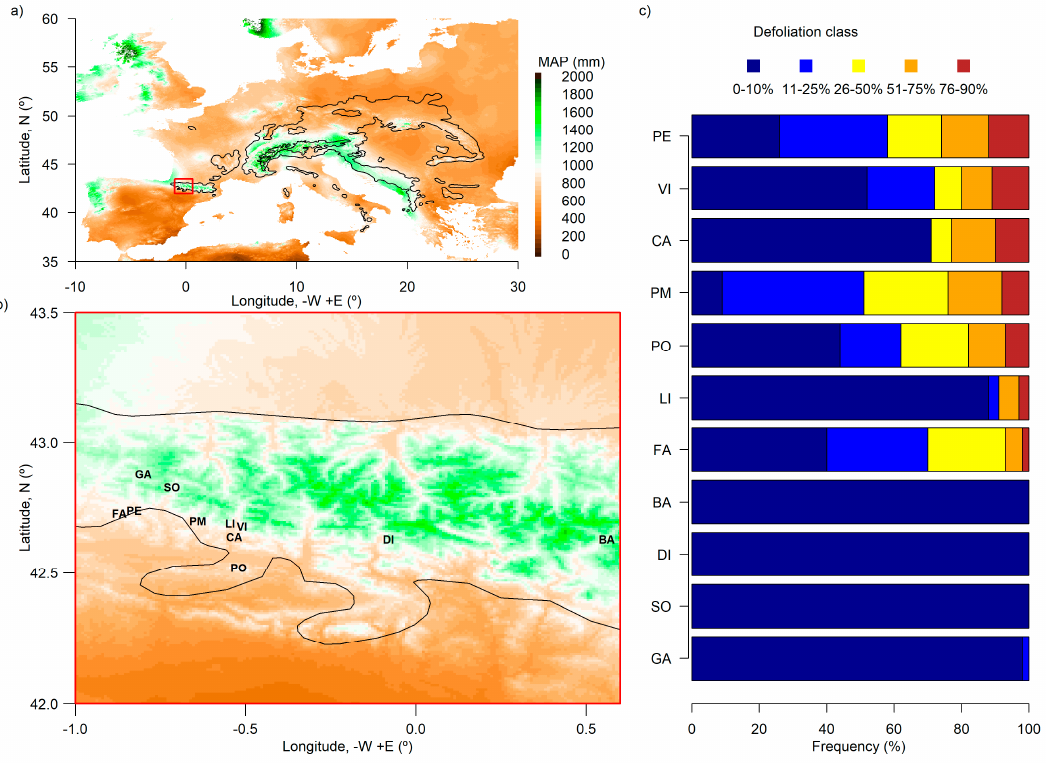
Figure 1. Location of the studied silver fir forests in Europe ( a ) and the Spanish Pyrenees ( b ) and defoliation degree ( c ) for each stand. The location of the studied site in Europe is highlighted by a red box in ( a ). The background map in ( a , b ) represents spatial variations in mean annual precipitation (MAP). Each stand is indicated with its code in ( b ). The black lines in ( a , b ) indicate the limits of the distribution range of silver fir. See site codes in Table 1.